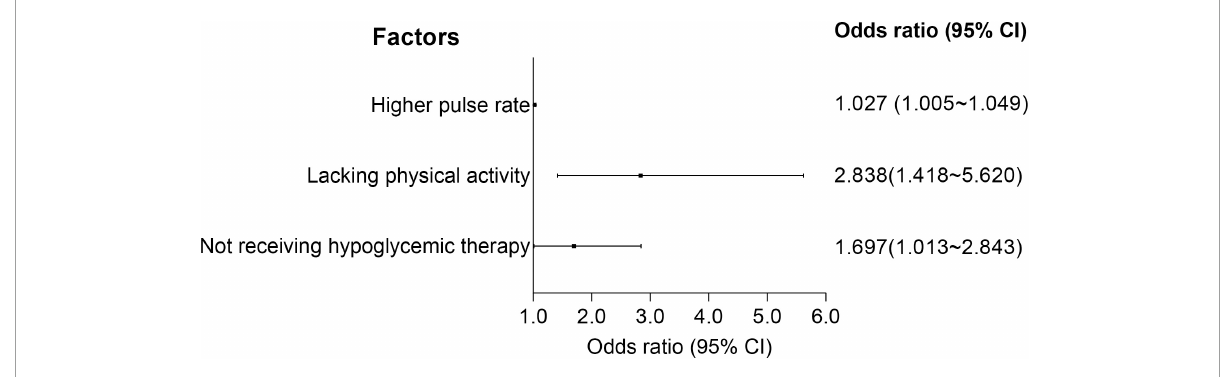
FIGURE4 Forest plots of logistic regression. CI, confidence interval.